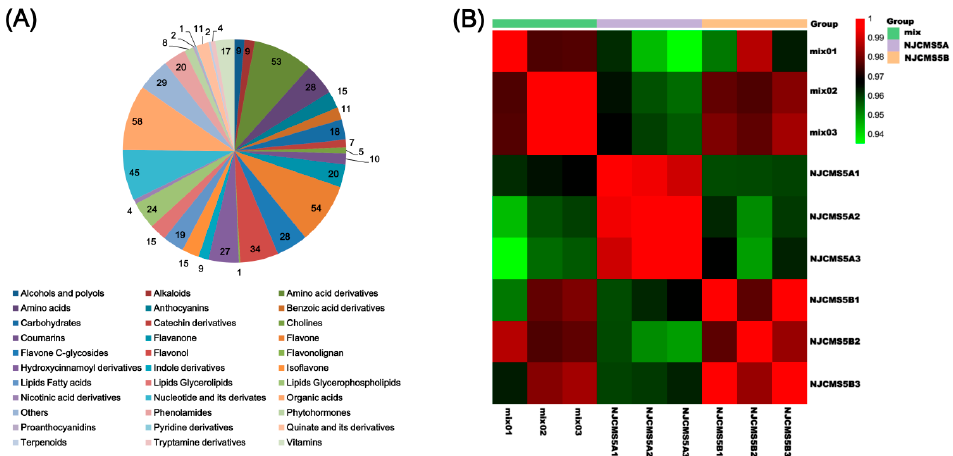
Figure 1. The distribution of identified metabolites in flower buds of NJCMS5A and NJCMS5B and the repeated correlation assessment (RCA) analysis. ( A ) The distribution of identified 612 metabolites in flower buds of NJCMS5A and NJCMS5B; ( B ) The RCA analysis of NJCMS5A, NJCMS5B, and mix. Mix, quality control sample.